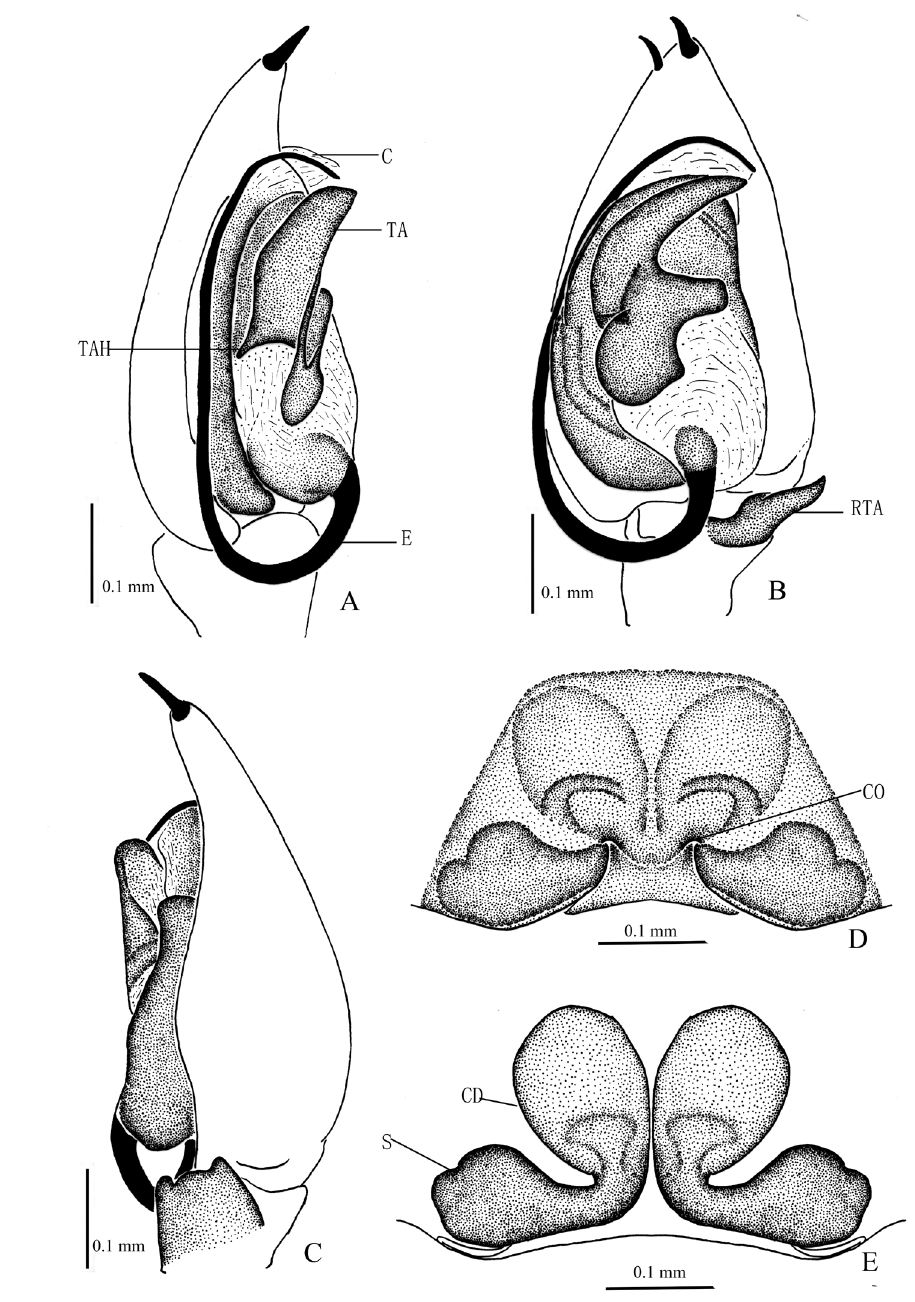
Figure 8. Zodarion ovatum sp. n., male holotype ( A–C ) and female paratype ( D, E ) A–C Left male palp ( A prolateral view B ventral view C retrolateral view) D Epigynum, ventral view E Vulva, dorsal view. Ab- breviations: C, conductor; CD, copulatory ducts; CO, copulatory opening; E, embolus; RTA, retrolateral tibial apophysis; S, spermatheca; TA, tegular apophysis; TAH, tegular apophysis